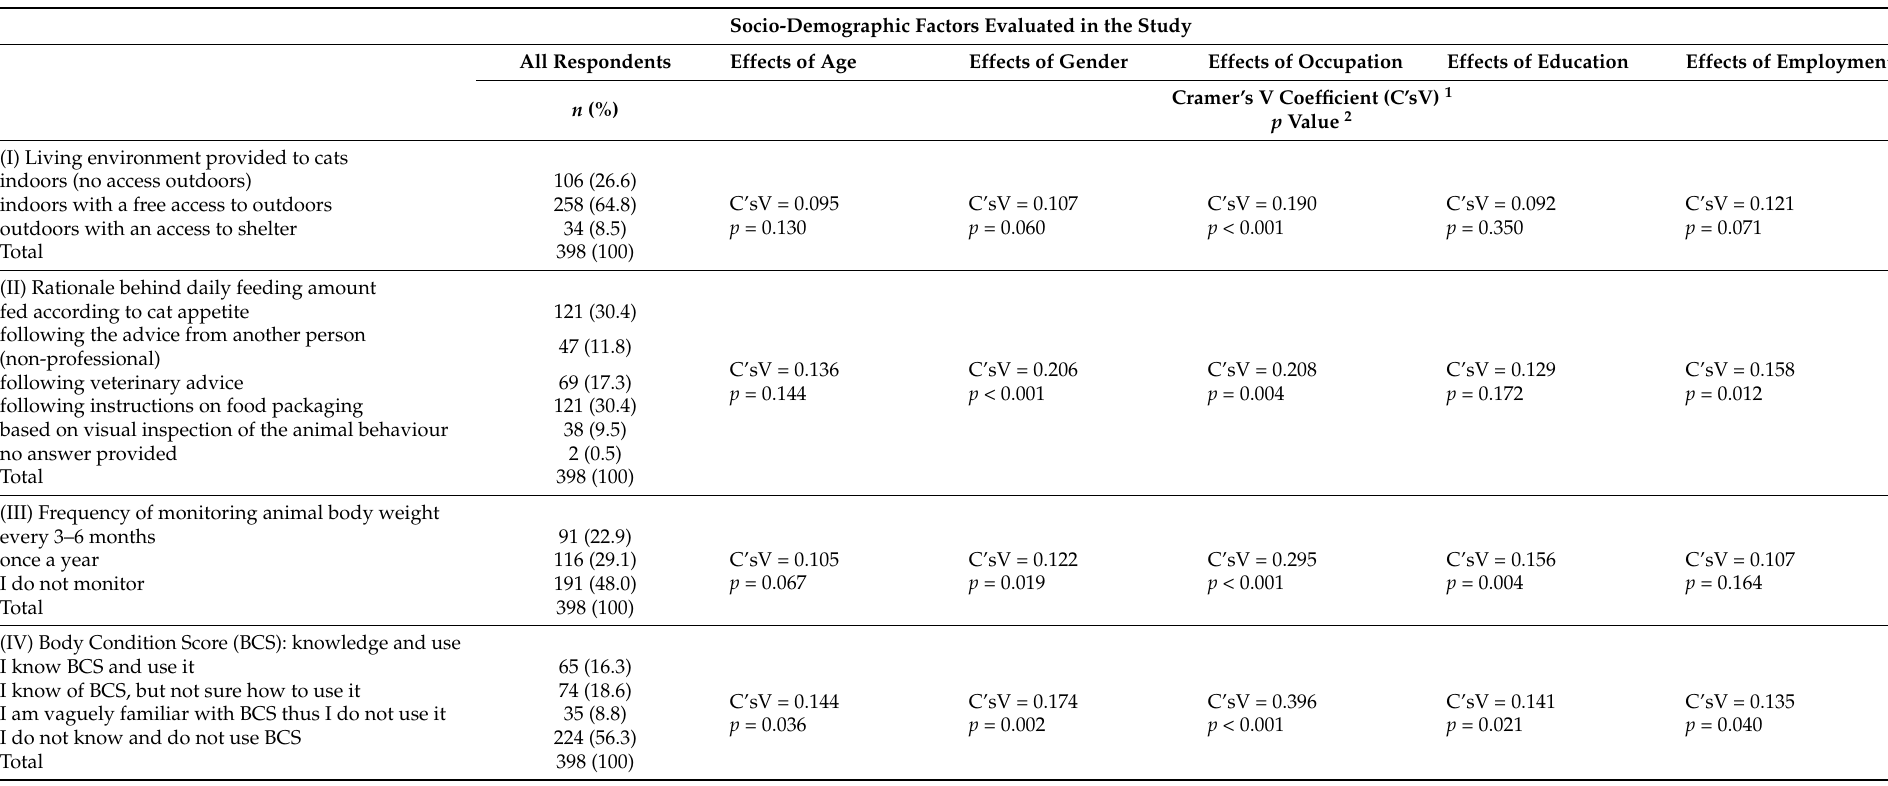
Table 5. Animals living environment and fundamental management practices, including, feeding practices, monitoring animal body weight and knowledge, and use of Body Condition Score (BCS) reported by the cat owners in this study. A full set of cross-tabulated results is shown in Supplementary Materials (Table